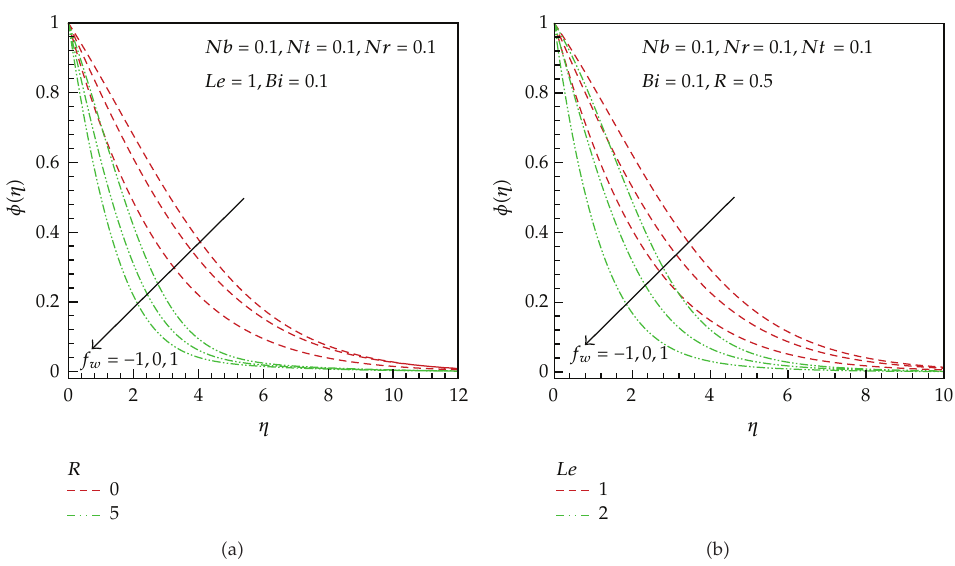
Figure 6: E ff ect of (cid:3) a (cid:4) radiation parameter, (cid:3) b (cid:4) Lewis number on the dimensionless nanoparticle volume fraction for di ff erent values of suction/injection